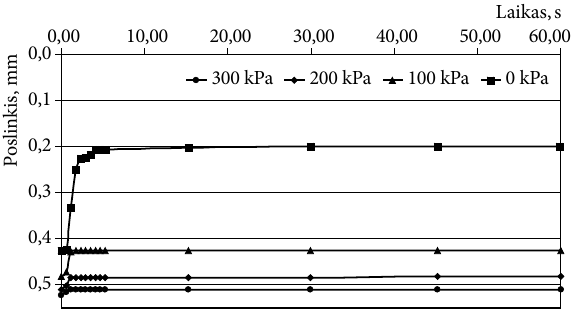
8 pav. Poslinkių priklausomybė nuo laiko laipsniškai nukraunant (1,18–0,6 mm dydžio frakcija) Fig. 8. Displacement versus time variation in unloading steps